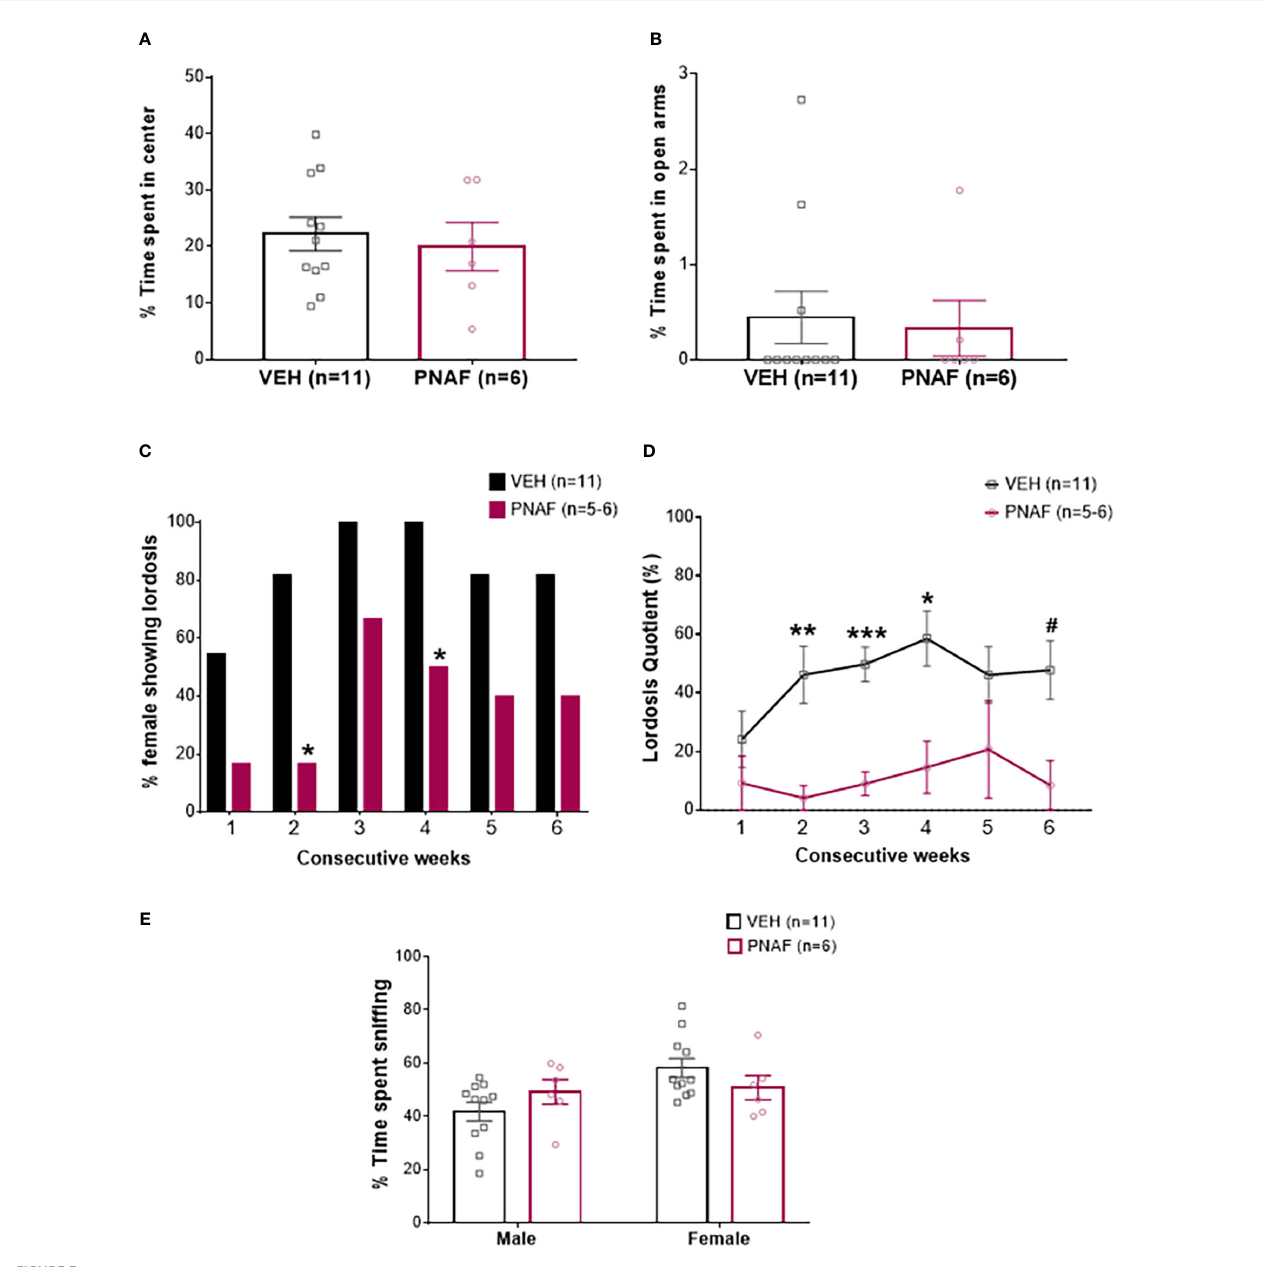
FIGURE 3 Prenatal DHT exposure signi fi cantly impairs female-typical sexual behavior in the prenatally-androgenized female mouse modeling PCOS. (A, B) Histograms representing the percentage of time spent in the center zone of the Open- fi eld test (A) and the percentage of time spent in the open arm of the Elevated- plus maze (B) for the VEH female (black bars) and PNAF (magenta bars). (C) Histograms representing the percentage of animals showing lordosis behavior for the VEH female (black bars) and PNAF (magenta bars) over 6 consecutive weeks of testing. (D) Graphical curve representing the percentage of lordosis quotient, i.e. the number of lordosis behavior divided by the number of male mount trial, over the 6 consecutive weeks of testing for the VEH female (black line) and PNAF (magenta line). (E) Histograms representing the percentage of time spent snif fi ng either the male or the female compartment in the three- compartment box partner preference test for the VEH female (black bars) and PNAF (magenta bars). # p<0.06, *p<0.05, **p<0.01, ***p<0.001. VEH, control female; PNAF, prenatally androgenized female. Mean +/-